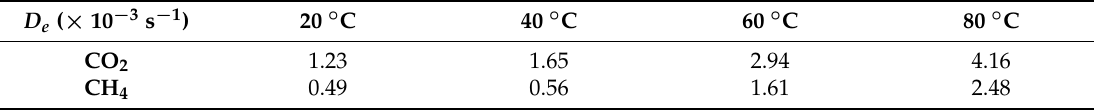
Table 3. The effective diffusion coefficients of CO 2 and CH 4 at 1 MPa.